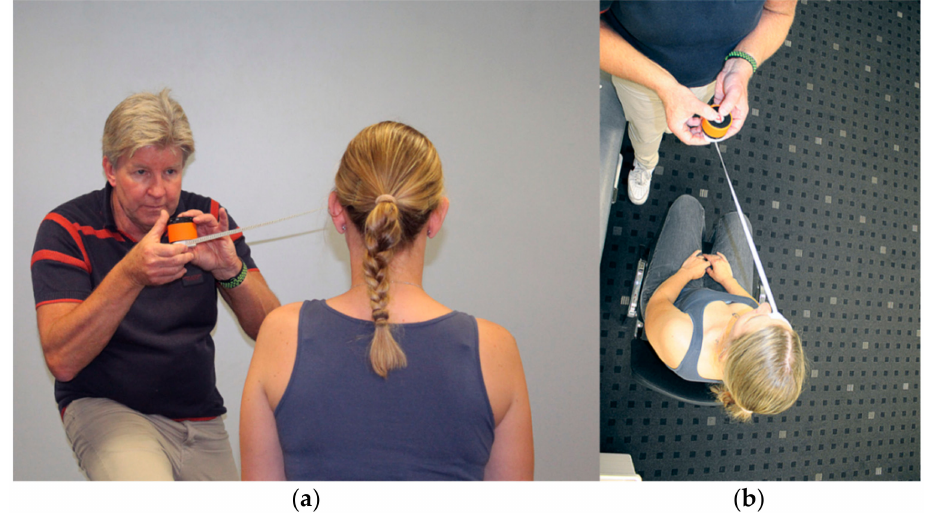
Figure 4. Assessment of auditory acuity. ( a ) With a loudspeaker with variable frequency (250–8000 Hz) and sound intensity (5–40 dB), it is possible to measure in different regions of the peripersonal space. ( b ) With a centimeter of light fixed on the head with a piece of tape, distances in space can easily be